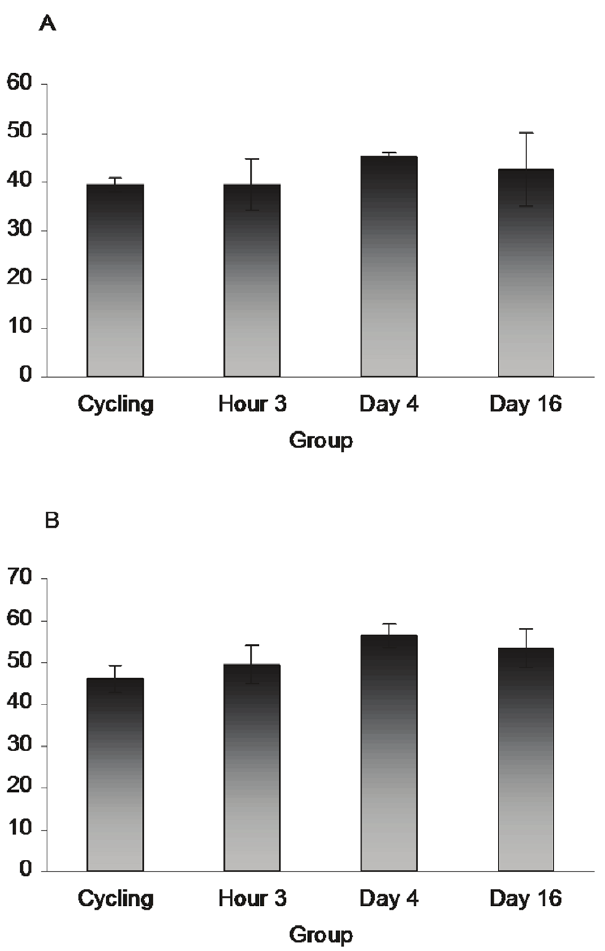
Figure 2. Representative photomicrographs of vimentin-ir in the MPOA. Panel A shows vimentin-ir of the MPOA of Cycling animals, and Day 16 (MPOA- panel B, Cg2 Panel C). Note the decrease in vimentin-ir within the MPOA during lactation and the relative absence of vimentin-ir cells within Cg2. Panels D and E show darkfield images of S100beta-ir within Cg2 of Cycling (D) and D16 (E) and in the MPOA of an H3 postpartum rat (F).